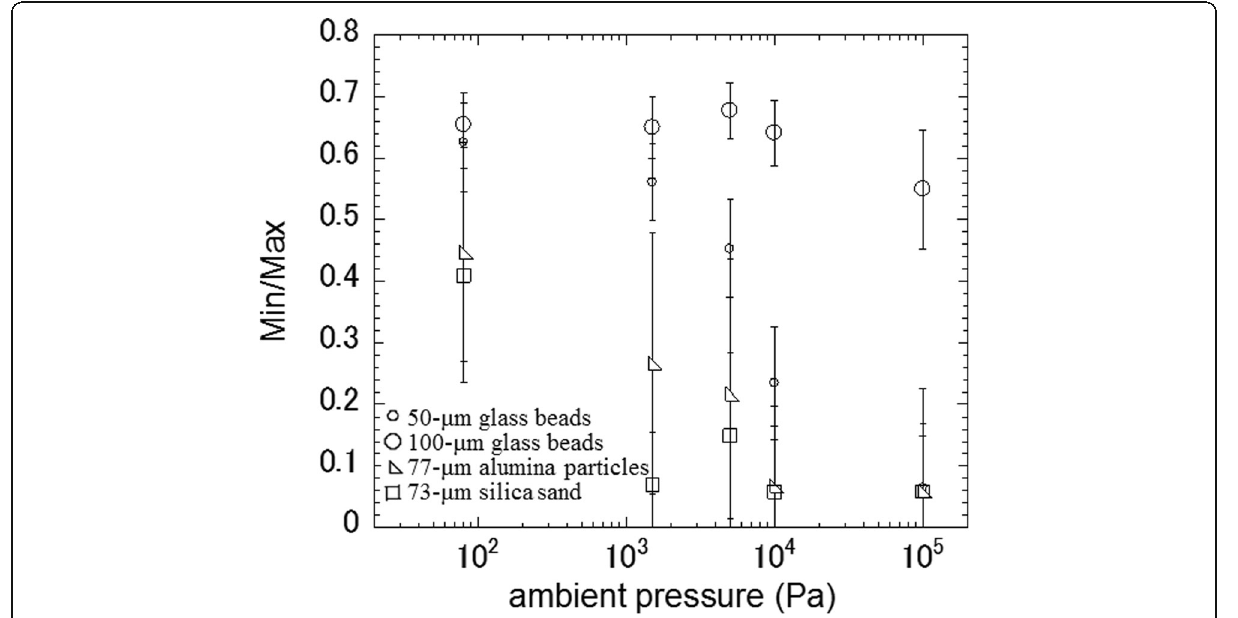
Fig. 12 Ratio of the local minimum width to the local maximum width of granular stream versus ambient